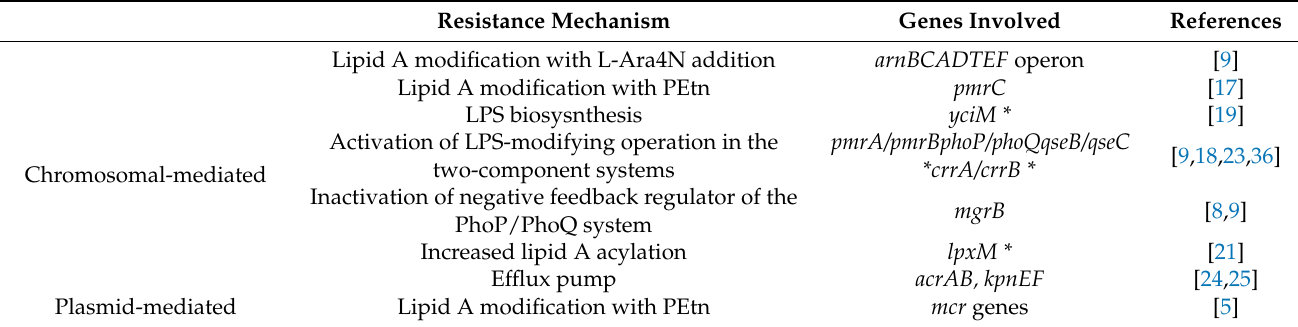
Table 1. Overview of colistin resistance in K. pneumoniae